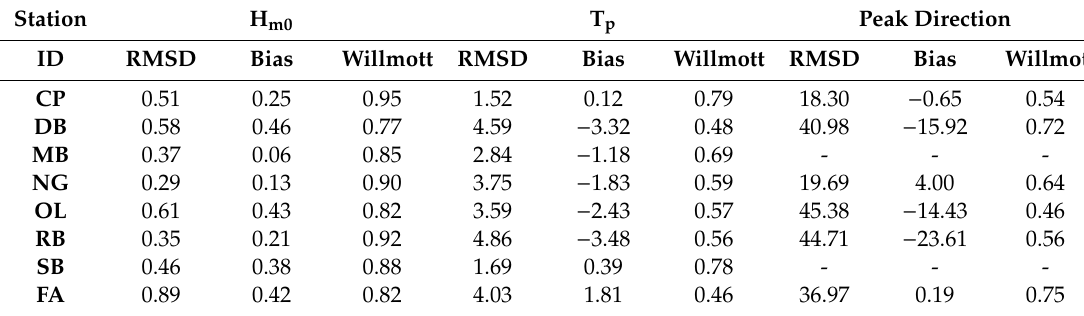
Table A4. Model performance statistics per coastal buoy location for JJA 2017, M4.